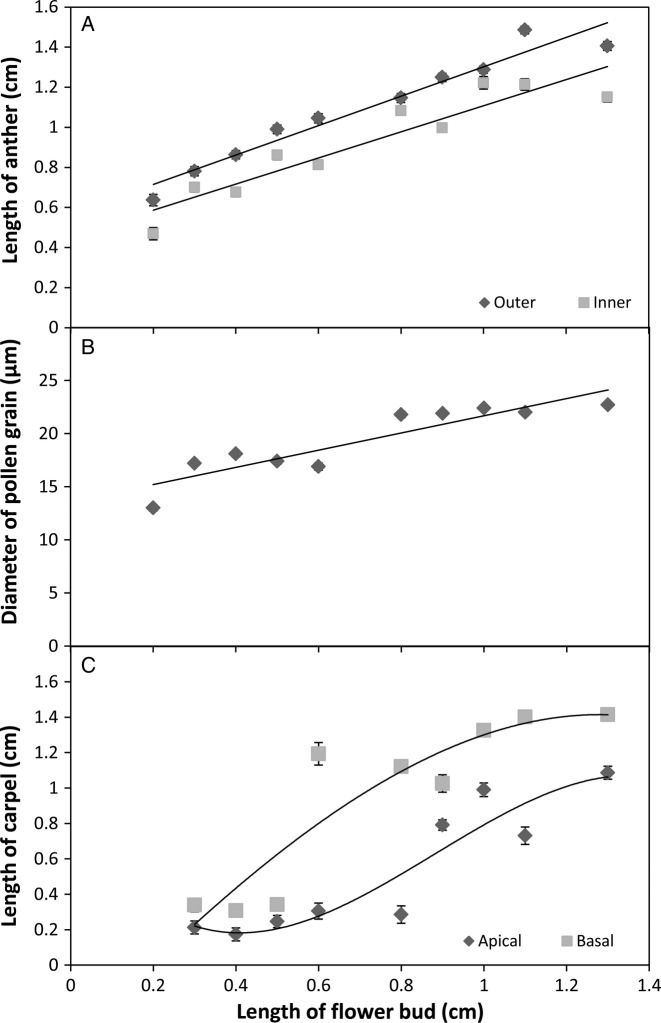
Relationship between the length of flower bud and length of outers and inners anthers (A), diameter of pollen grain (B) and length of carpels in apical and basal region of the receptacle (C). Each data point is the mean ± SE, n = 9–45. Fitting models of regression depicted are: length of outer anthers = 0.734x + 0.5679, R2 = 0.95; Length of inner anthers = 0.6513x + 0.456, R2 = 0.87; Pollen grain diameter = 8.0943x + 13.593, R2 = 0.82; Length of apical carpels = −2.1203x3 + 5.6x2 − 3.5177x + 0.8289, R2 = 0.86; Length of basal carpels = −0.3122x3 − 0.3387x2 + 2.4045x − 0.4533, R2 = 0.84.